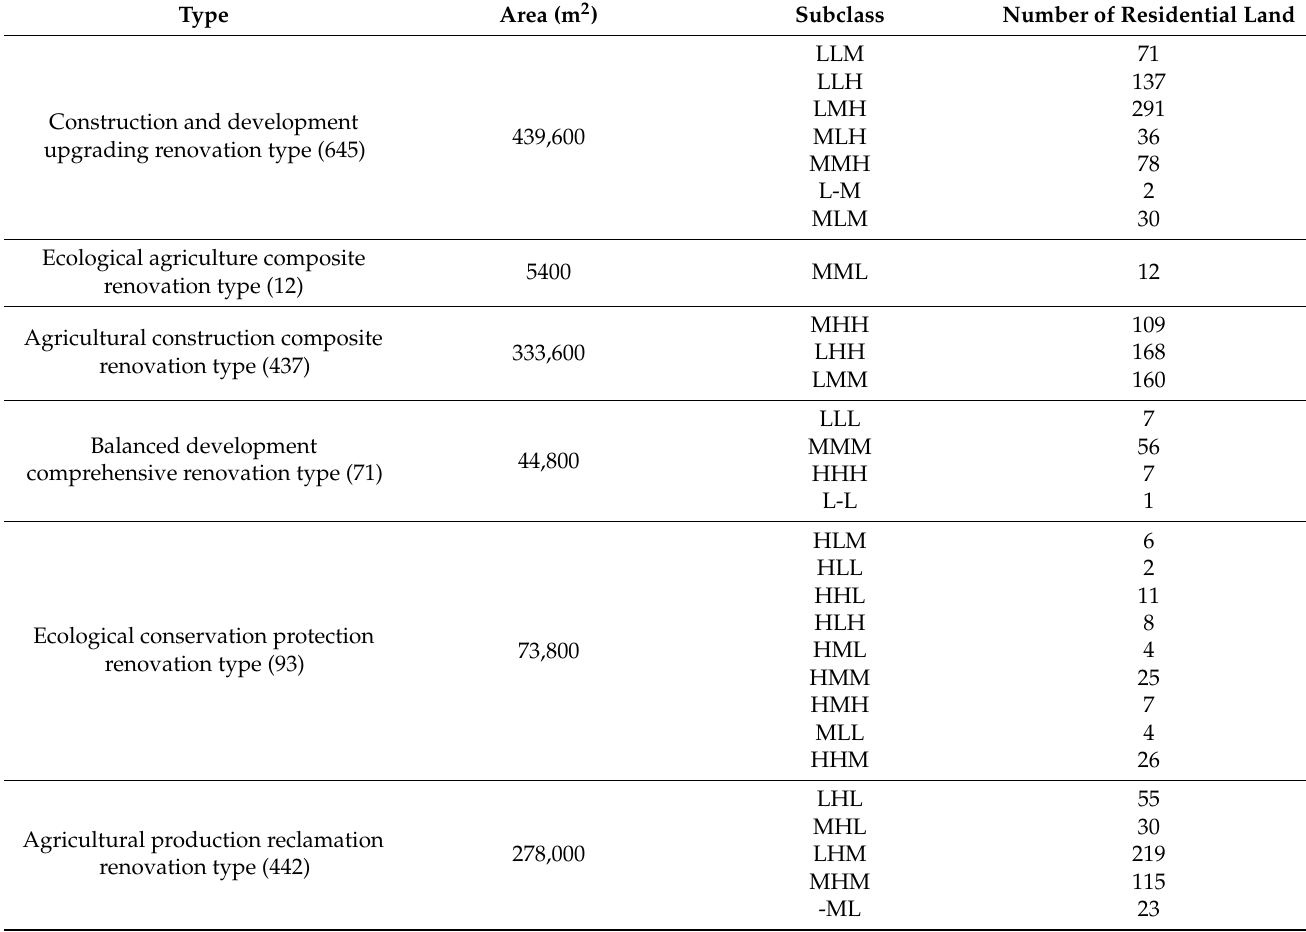
Table 3. Statistical table of the idle residential renovation